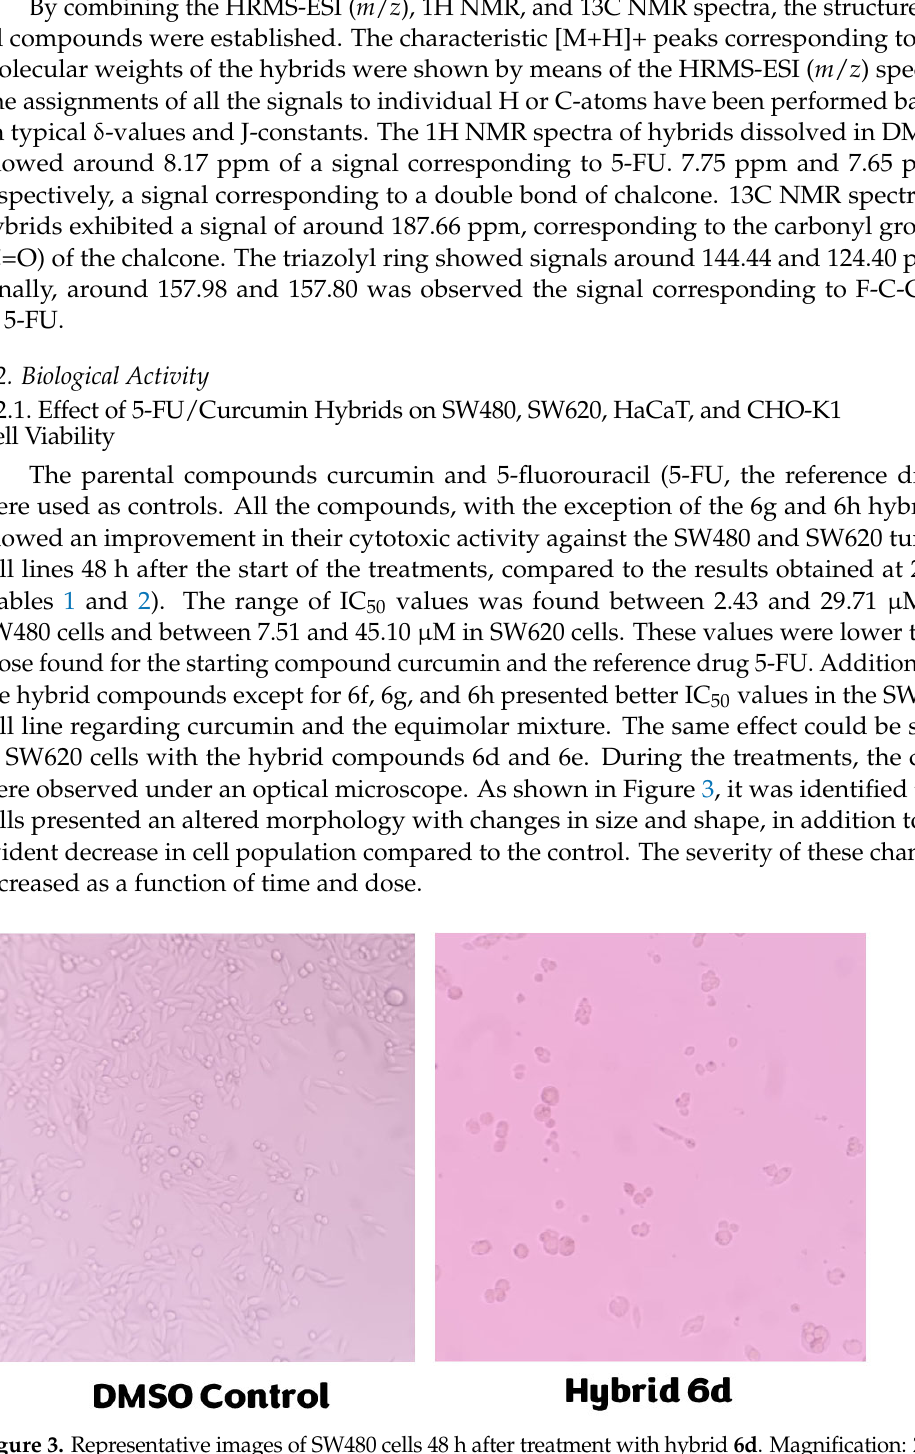
Figure 3. Representative images of SW480 cells 48 h after treatment with hybrid 6d . Magnification: 20 × . The increase in cytotoxic activity over time was also reflected in some of the results obtained on the non-tumor cell lines HaCaT and CHO-K1, a situation that negatively affects the selectivity indices (SI) by generating a decrease in them. Only compounds 6a and 6d in SW480 cells and compounds 6d and 6e in SW620 cells increased their SI over 48 h post-treatment; moreover, these same compounds presented the lowest IC 50 compared to the starting compounds and the equimolar